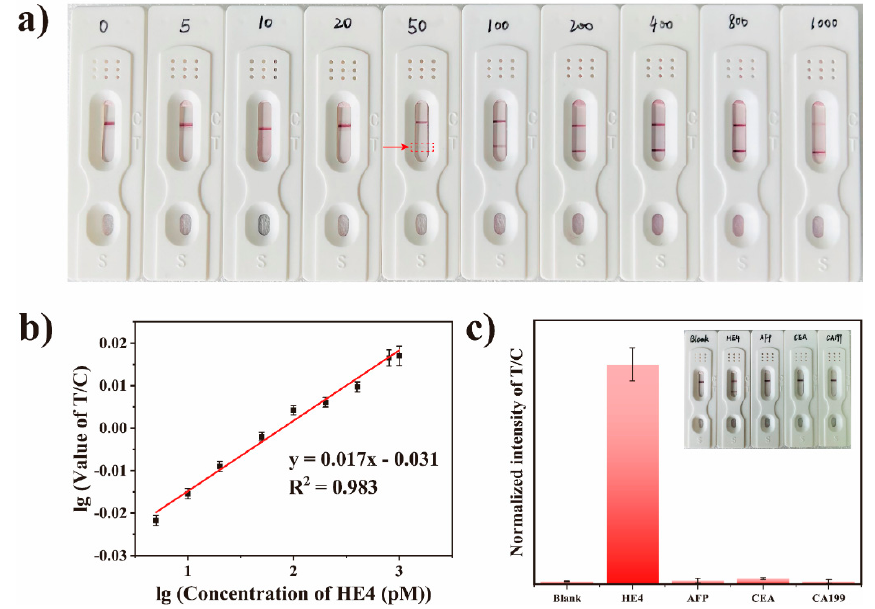
Figure 5. ( a ) Photograph of the MF@Au@PEI − LFIA when detecting different concentrations of HE4 (0, 5, 10, 20, 50, 100, 200, 400, 800, and 1000 pM). ( b ) Linear response of MF@Au@PEI − LFIA for detection of HE4 in the concentration range of 50 − 1000 pM. ( c ) Specificity of MF@Au@PEI − LFIA for different biomarkers (AFP, CEA, CA199).